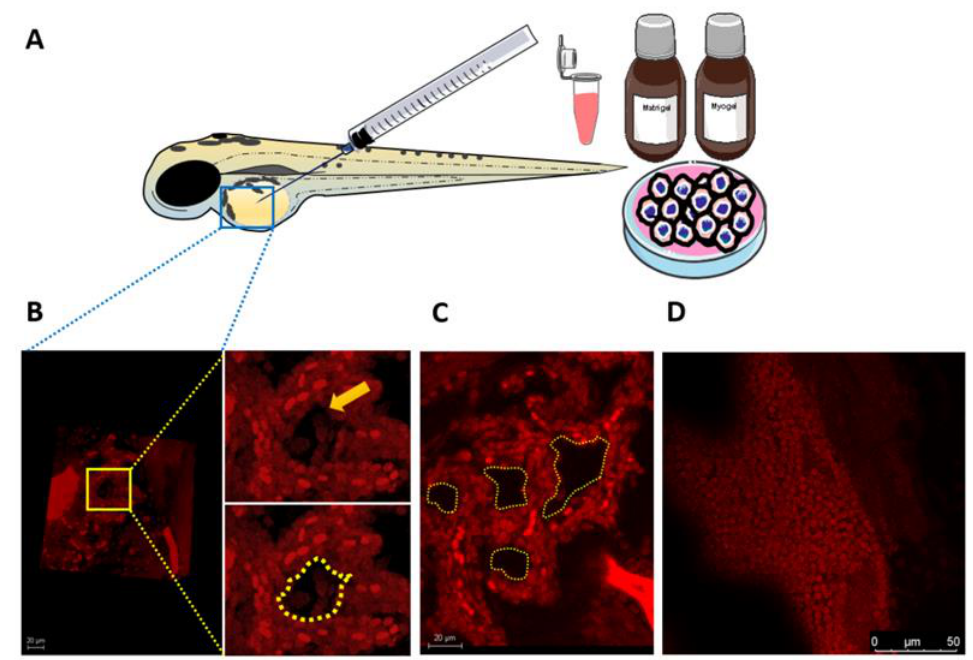
Figure 5. Larval zebrafish model to evaluate vascular mimicry (VM) formation in vitro. ( A ) Fluo- rescently labelled highly metastatic tumour cells (HSC-3) were resuspended in Matrigel or Myogel and microinjected into the perivitelline space of 2-day-old zebrafish larvae. Fish were screened 27 h post-injection using confocal microscopy. ( B , C ) HSC-3 cells formed seemingly VM-like structures in the Matrigel-injected fish. ( D ) No similar tube formation was detected in Myogel-containing fish, supporting a similar outcome from the in vitro assays. Scale bars: 20 and 50 µ